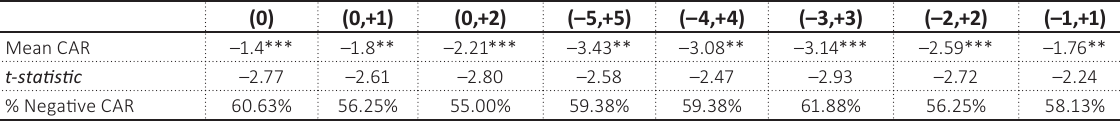
Table 2. Cumulative abnormal returns around rights issue announcements: All firms